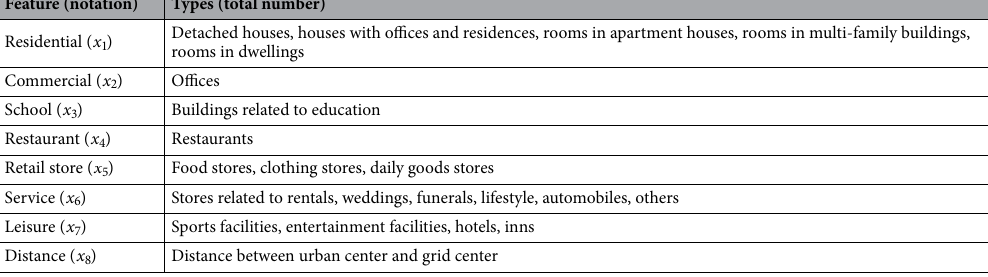
Table 2. Features to be used as explanatory